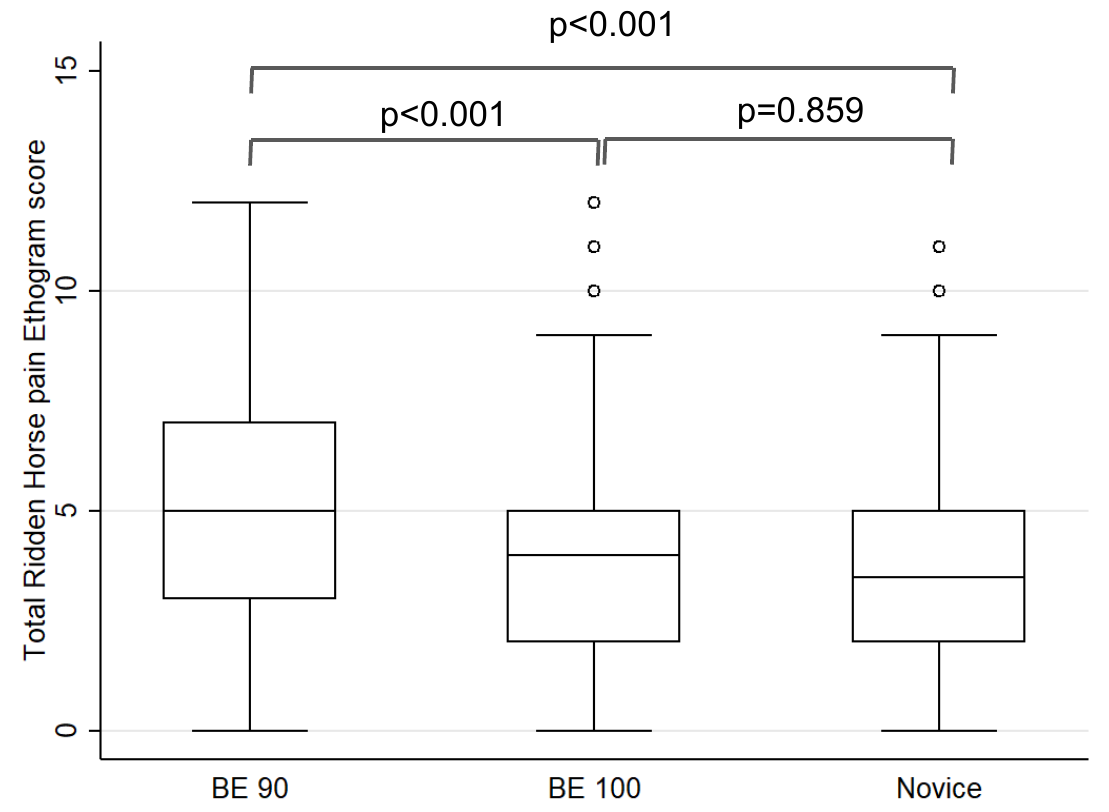
Figure 1. Box and whisker plots for the total Ridden Horse Pain Ethogram scores during the dressage phase compared with competition level (British Eventing [BE] 90, 100 and Novice) for 1009 competition starts (one horse at Novice level was eliminated in the dressage). Boxes represent medians and interquartile ranges; whiskers represent the range and individual points outliers. The median RHpE scores were significantly higher for BE 90 compared with both BE 100 and Novice.